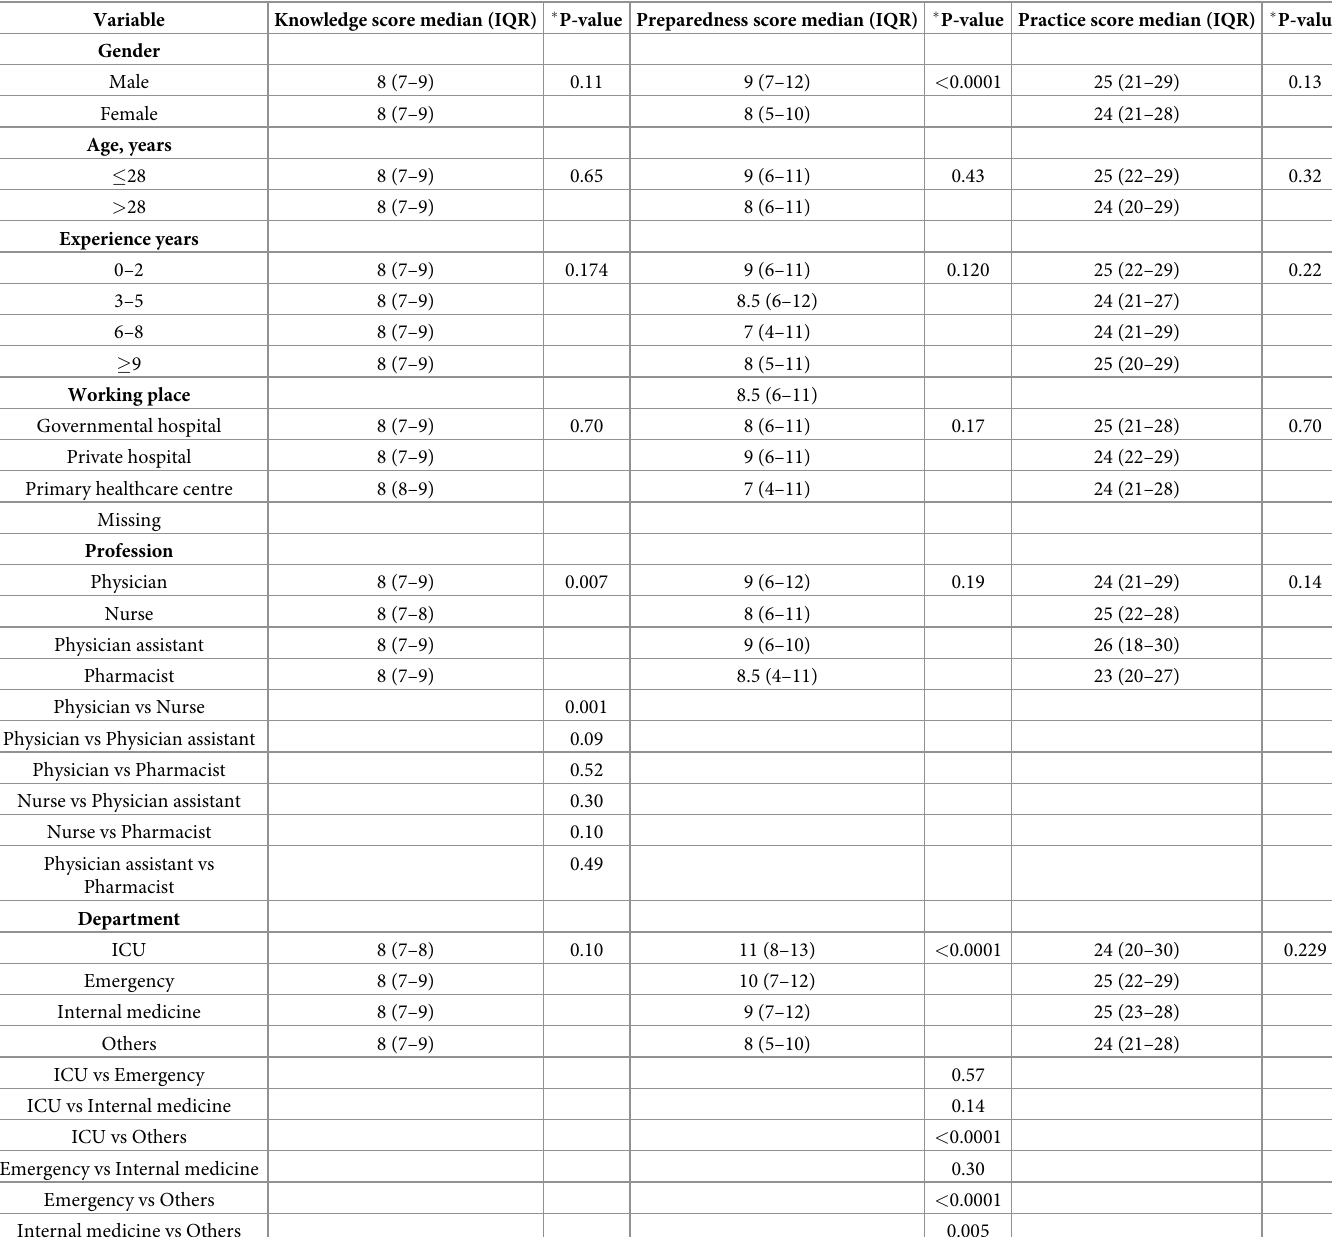
Table 5. The effect of demographic factors on knowledge, preparedness and counseling